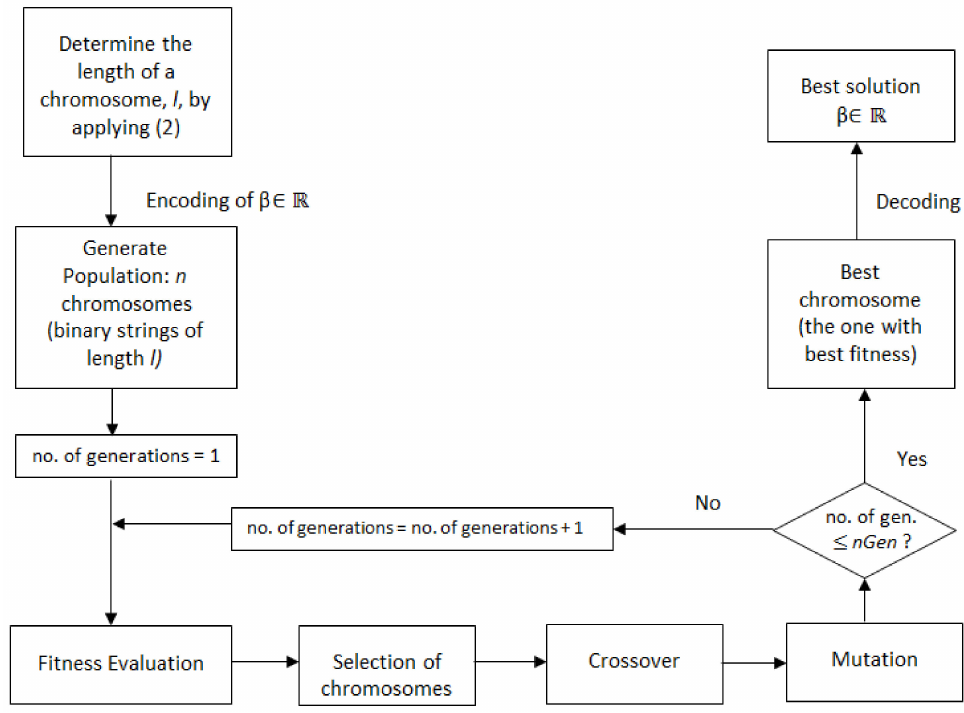
Figure 1. The procedure flow chart. nGen represents the maximum number of